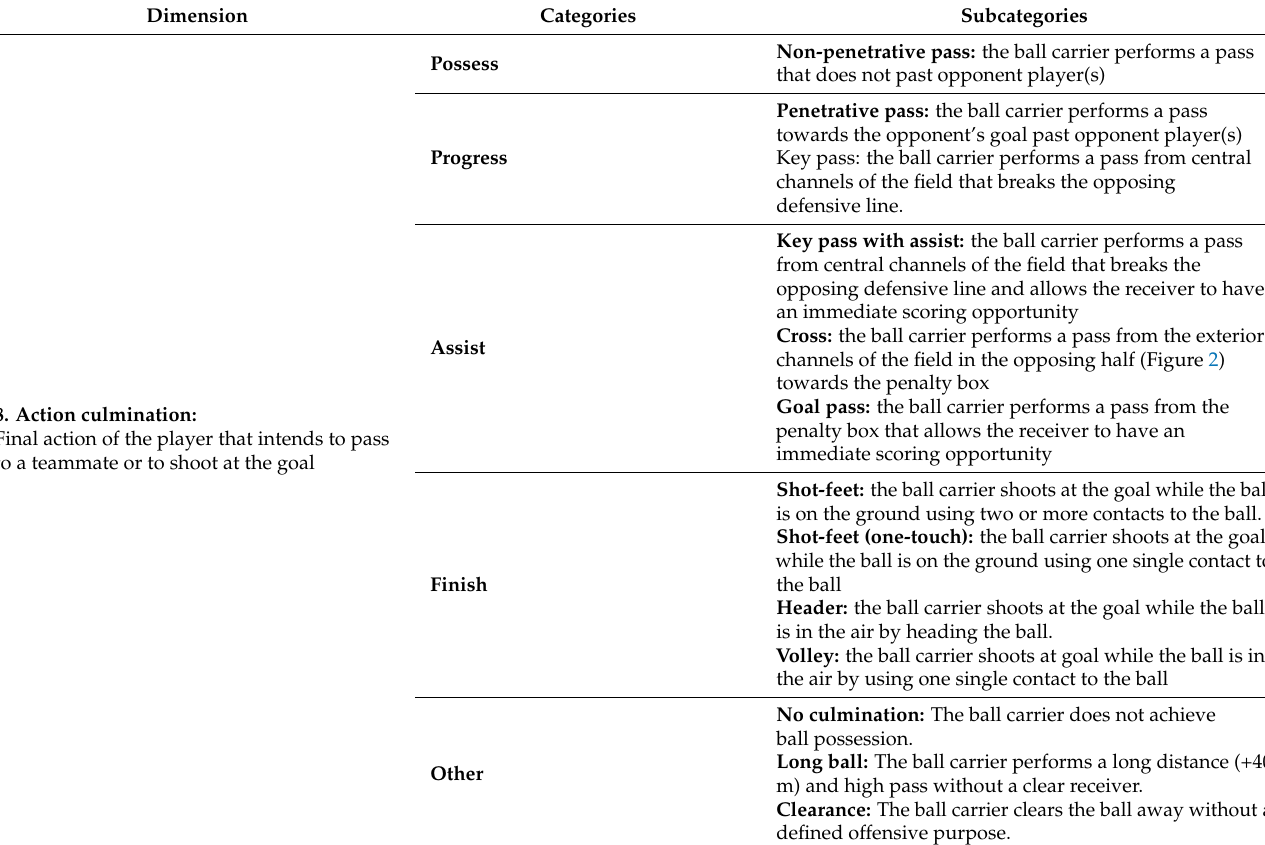
Table 3. Operational definitions for the dimensions included in the moment of culminating the